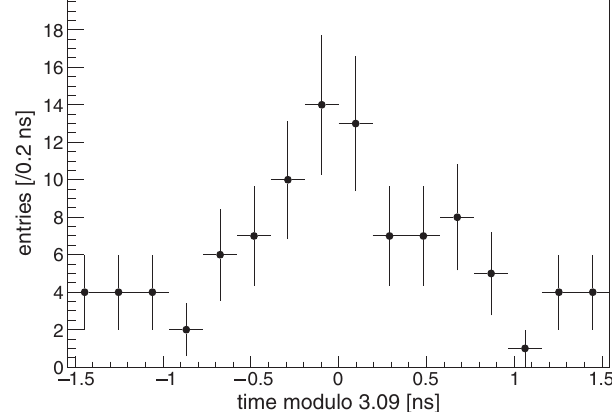
FIG. 9. Pulse height distribution of the signal-contained events (ON-TIME) and background events (OFF-TIME). The OFF- TIME events are normalized so that the number of OFF-TIME events whose pulse height is less than 600 mV is equal to that of the ON-TIME events. The applied pulse-hight cut of 800 mV is indicated with the solid line with the arrow.